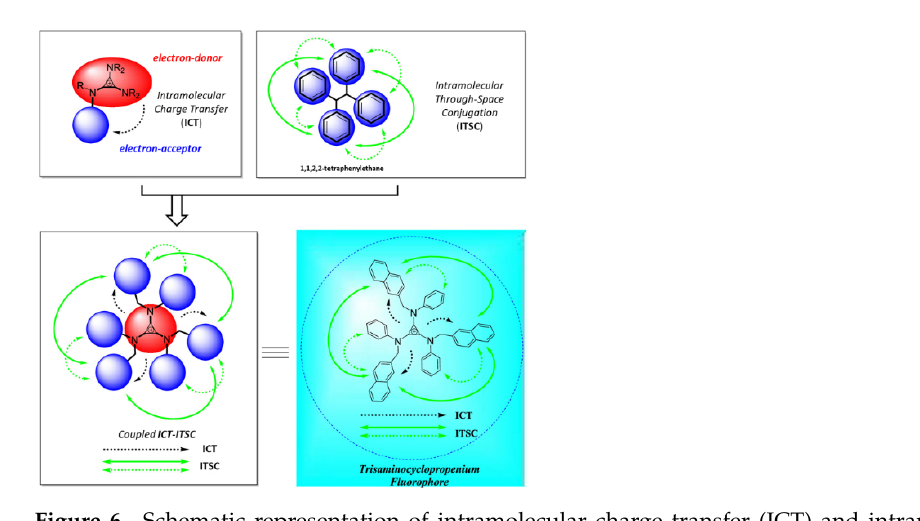
Figure 6. Schematic representation of intramolecular charge transfer (ICT) and intramolecular through-space conjugation (ITSC) and the coupling of these processes in trisaminocyclopropenium fluorophores. Reprinted with permission from Ref. [105] . Copyright 2020, American Chemical Society.